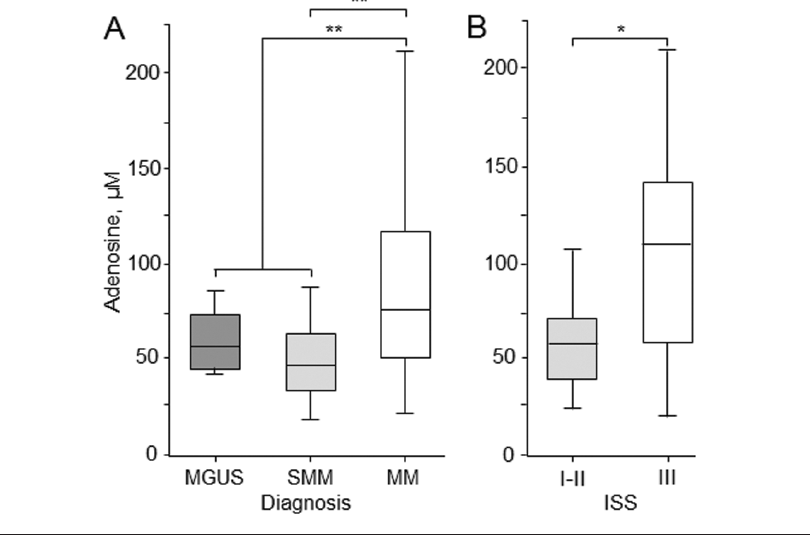
Figure 2. Correlation of ADO levels with diagnosis and ISS stage. HPLC analysis of ADO levels in plasma obtained from BM aspirates from 39 patients at different stages of dis- ease. (A) Median ADO levels from five patients with MGUS (median = 56.70 µ mol/L; range: 42.29–85.90 µ mol/L), 13 with SMM (median = 42.00 µ mol/L; range: 18.40–87.39 µ mol/L) and 21 with MM (median = 69.88 µ mol/L; range: 22.00–210.84 µ mol/L). (B) ADO levels in BM plasma from symptomatic MM patients, compared by ISS staging. Median ADO levels from eight patients with MM ISS I-II (median = 59.57 µ mol/L; range: 39.26–107.8 µ mol/L) and 13 with MM ISS III (median = 110.30 µ mol/L; range: 22.00–210.84 µ mol/L). The P value was calculated using the Mann-Whitney U